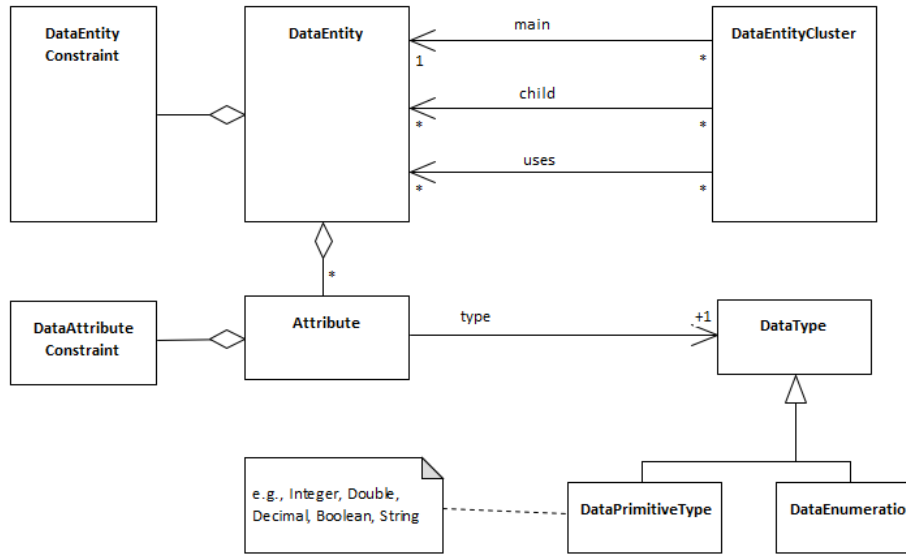
Figure 2. RSL partial metamodel with data entities related constructs (UML notation).